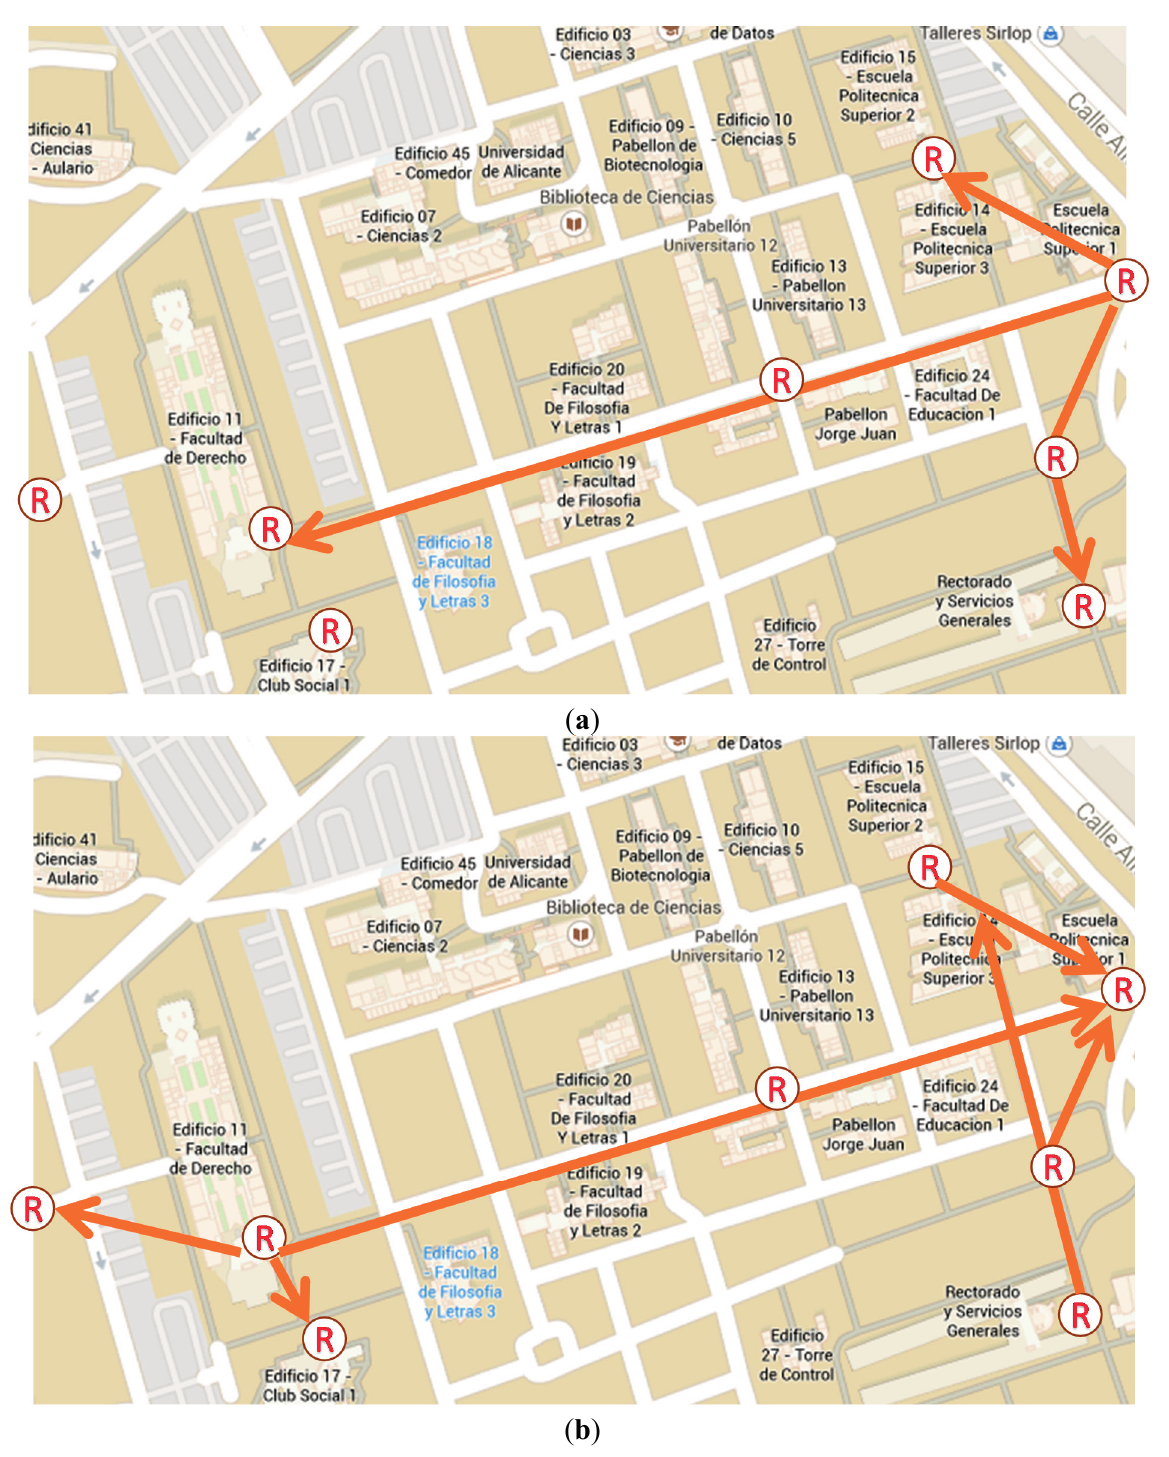
Figure 15. Temporal visualizations on the University Alicante campus with flow patterns: ( a ) temporal flow between 7.00 and 9.00 h; ( b ) temporal flow between 12.00 and 14.00